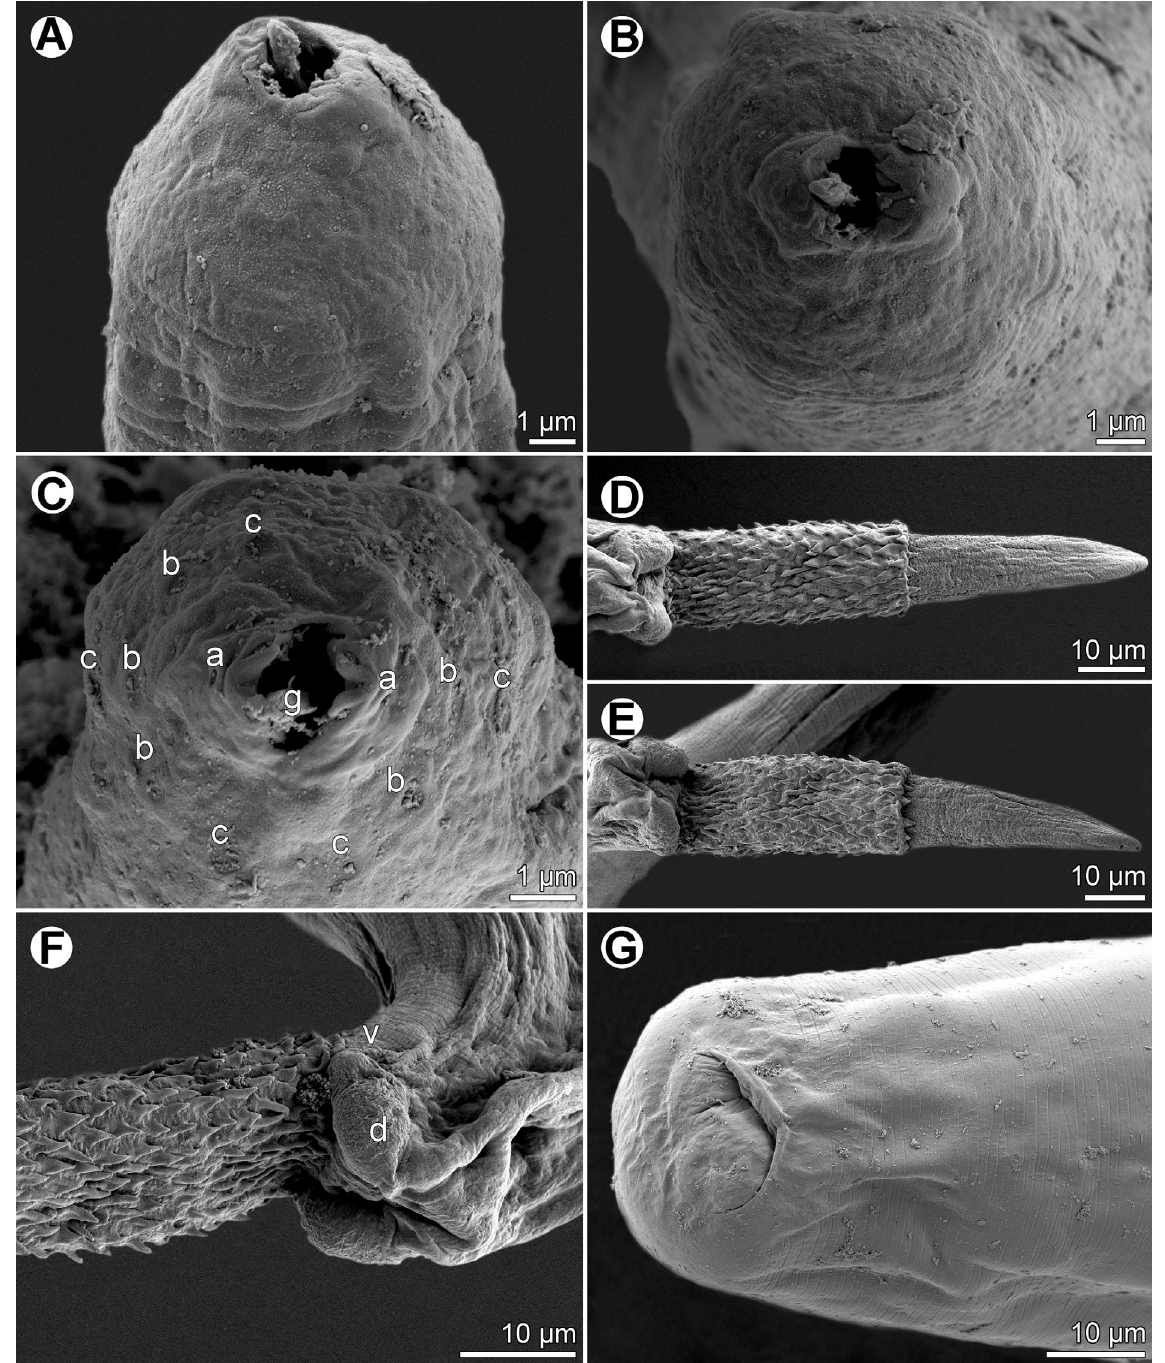
Figure 2. Capillaria plectropomi n. sp. from Plectropomus leopardus , scanning electron micrographs. A, B: cephalic end, dorsoventral and apical views. C: same, apical view (different specimen). D, E: male caudal end with extruded spicule and spinose spicular sheath, dorsal views (two different specimens). F: caudal end of male, lateral view. G: caudal end of female, ventral view. Abbreviations : a, amphid; b, cephalic papilla of inner circle; c, cephalic papilla of outer circle; d, male dorsolateral caudal lobe; g, stylet; v, lateral caudal